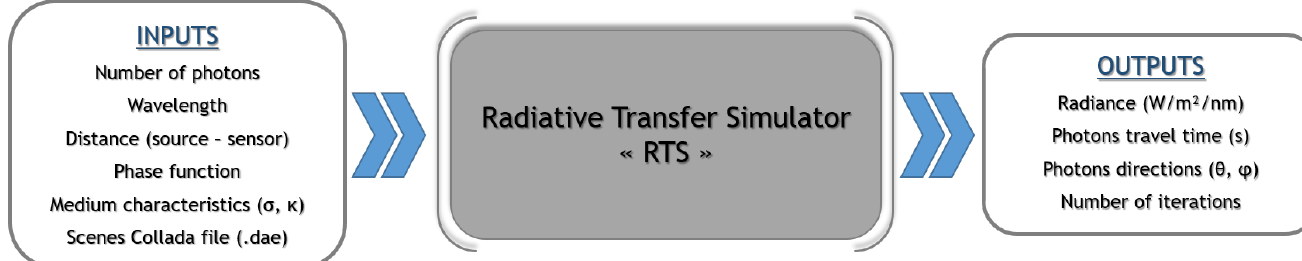
Figure 2. Illustration of the main inputs–outputs of the SWEET